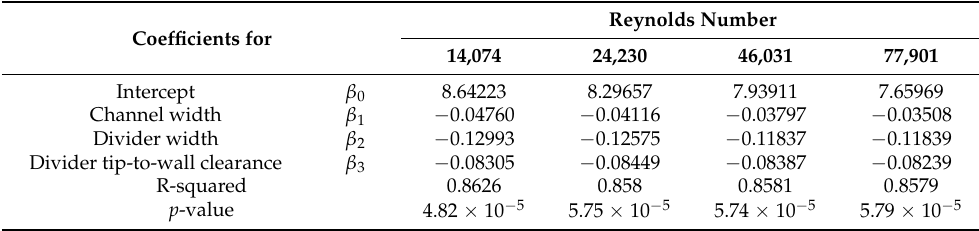
Table 5. Summary of the regression analysis in